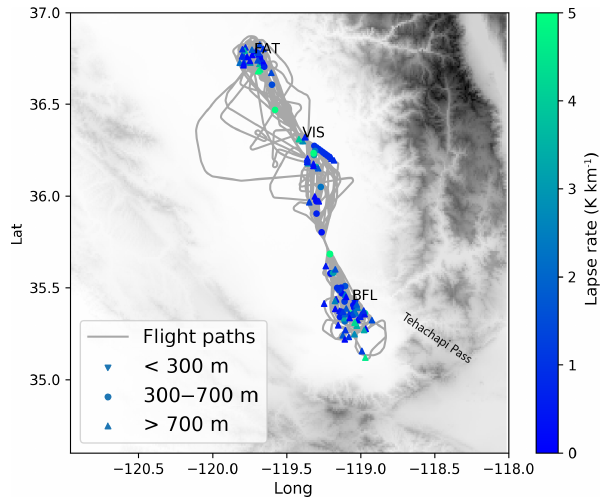
Figure 13. Detected nocturnal elevated mixed layers with at least 50m thickness, with elevations